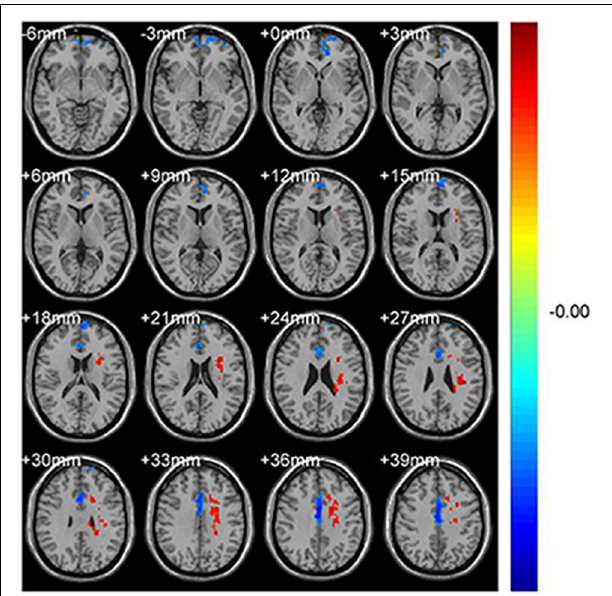
FIGURE 1 | Significant differences in fALFF values between the CS group and HCs. The brain regions with different fALFF values are the Frontal_Sup_Medial_L and the Cingulum_Mid_R. The red areas denote higher fALFF brain regions and blue areas denote lower fALFF brain